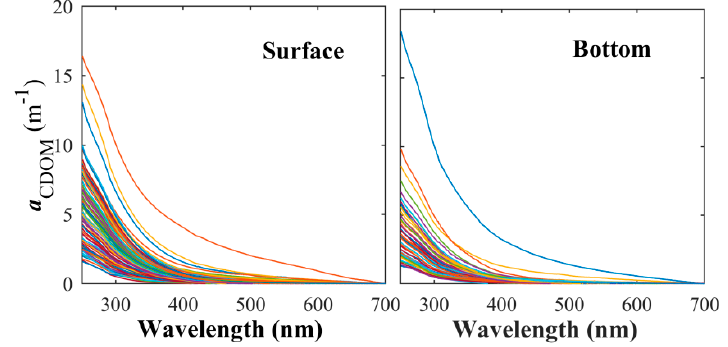
Figure 3. Chromophoric dissolved organic matter (CDOM) absorption curves over the wavelength range of 250–700 nm, measured at the water surface and at the bottom in the Pearl River Estuary.